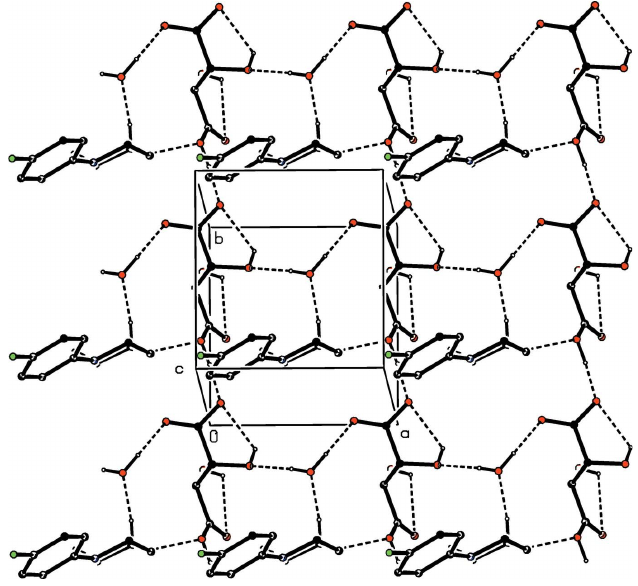
Figure 7 Part of the crystal structure of compound (III) showing the formation of a hydrogen-bonded sheet lying parallel to (001). Hydrogen bonds are drawn as dashed lines and, for the sake of clarity, the H atoms bonded to C atoms have been